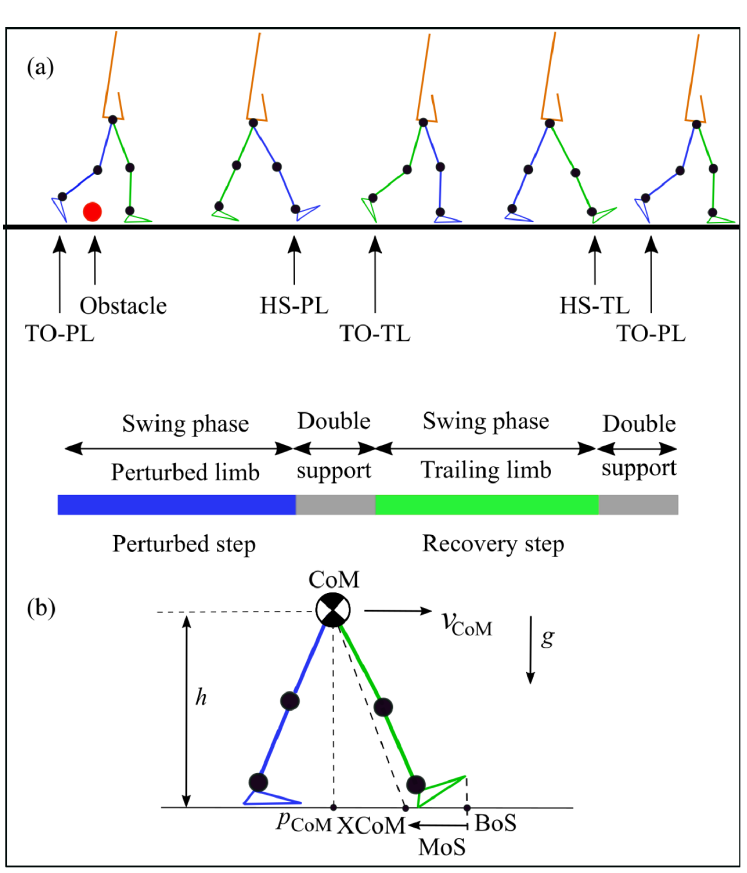
Fig 2. Gait cycle and margin of stability definitions. (a) TO-PL and HS-PL are toe-off and heel-strike events of the perturbed limb, and TO-TL and HS-TL are toe-off and heel-strike events of the trailing limb. The gait cycle is defined between two consecutive toe-offs of a perturbed limb (before and after hitting the obstacle). The perturbed step is the step in which the swing leg hits the obstacle. The recovery step is the step taken by the trailing limb after the perturbed step. (b) The margin of stability (MoS) is defined as the extrapolated center of mass position (XCoM) with respect to the position of the toe of the leading foot at heel-strike, the anterior extremum of the base of support (BoS). The anterior-posterior position of the CoM ( p CoM ) and velocity of the CoM ( v CoM ), height of the CoM above the ground ( h ), and gravitational acceleration ( g ) are used to calculate the XCoM.